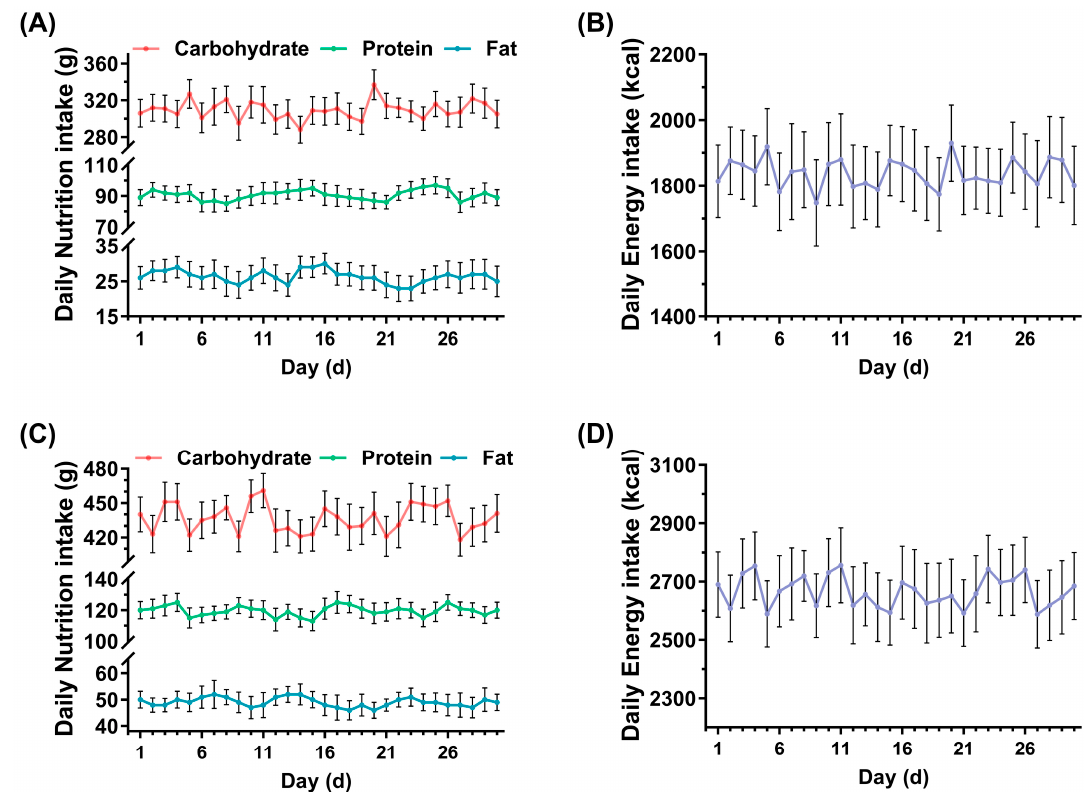
Figure 3. Daily records of carbohydrate, protein, fat and energy in dietary intake. Daily nutrition intake ( A ) and energy intake ( B ) of resistance exercise-untrained volunteers (n = 48). Daily nutrition intake ( C ) and energy intake ( D ) of resistance exercise-trained volunteers (n = 24).